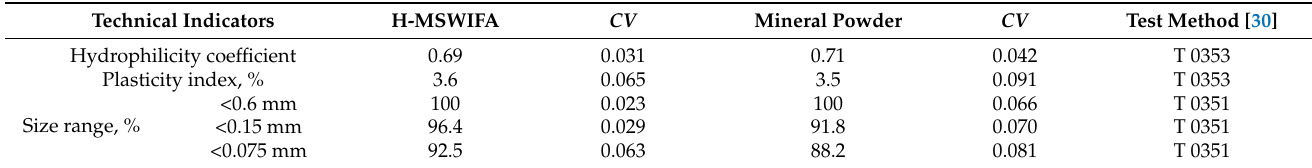
Table 2. Technical performance of H-MSWIFA and mineral powder.